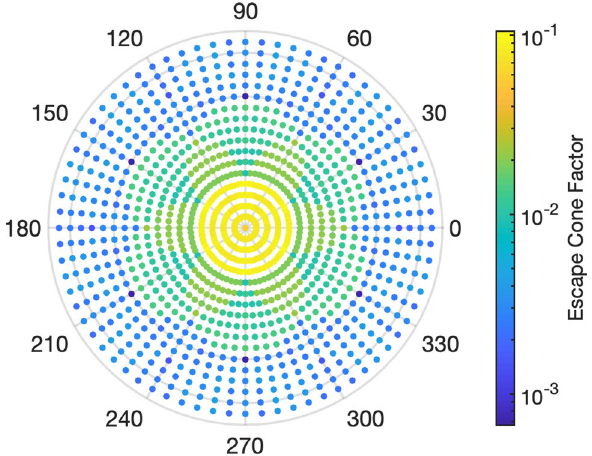
Figure 5. Normalized power scattered into the escape cone dependent on the incident angle of the light that has been reflected back from the substrate. See Fig. 1a. for description of escape cone and multiple passes through the